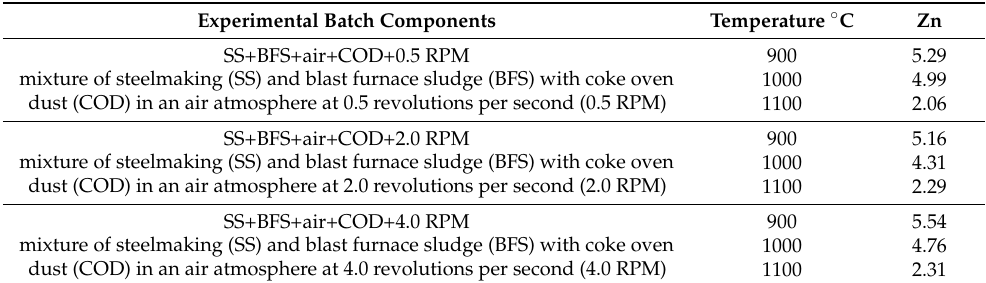
Table 6. Chemical composition of the experiments performed for the mixture of steelmaking and blast furnace sludge, at different speeds [wt.%] XRFS